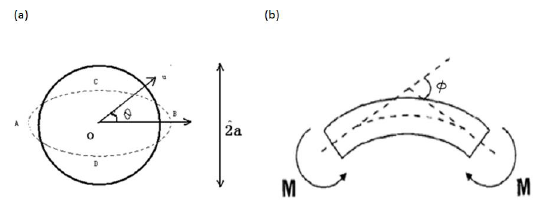
Figure 1. Elliptical cross section model for tube